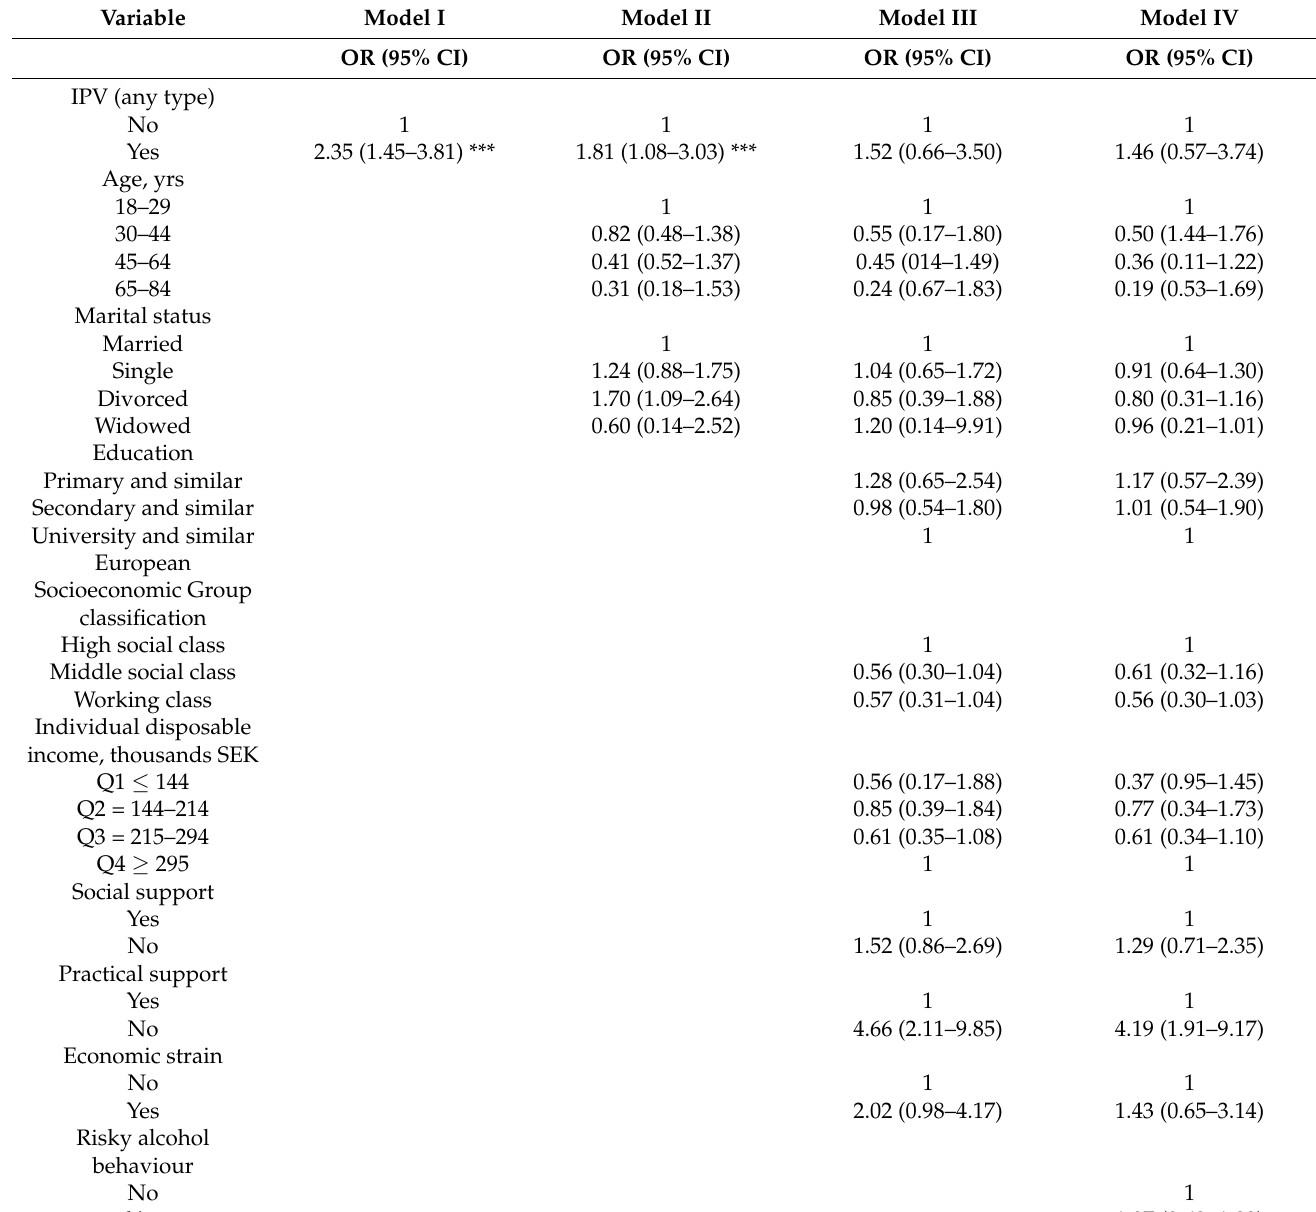
Table 2. Odds ratios (ORs) with 95% confidence intervals (CIs) for the relationship between inter- personal violence (IPV) and stress among men, according to the Gävleborg Health on Equal Terms Survey